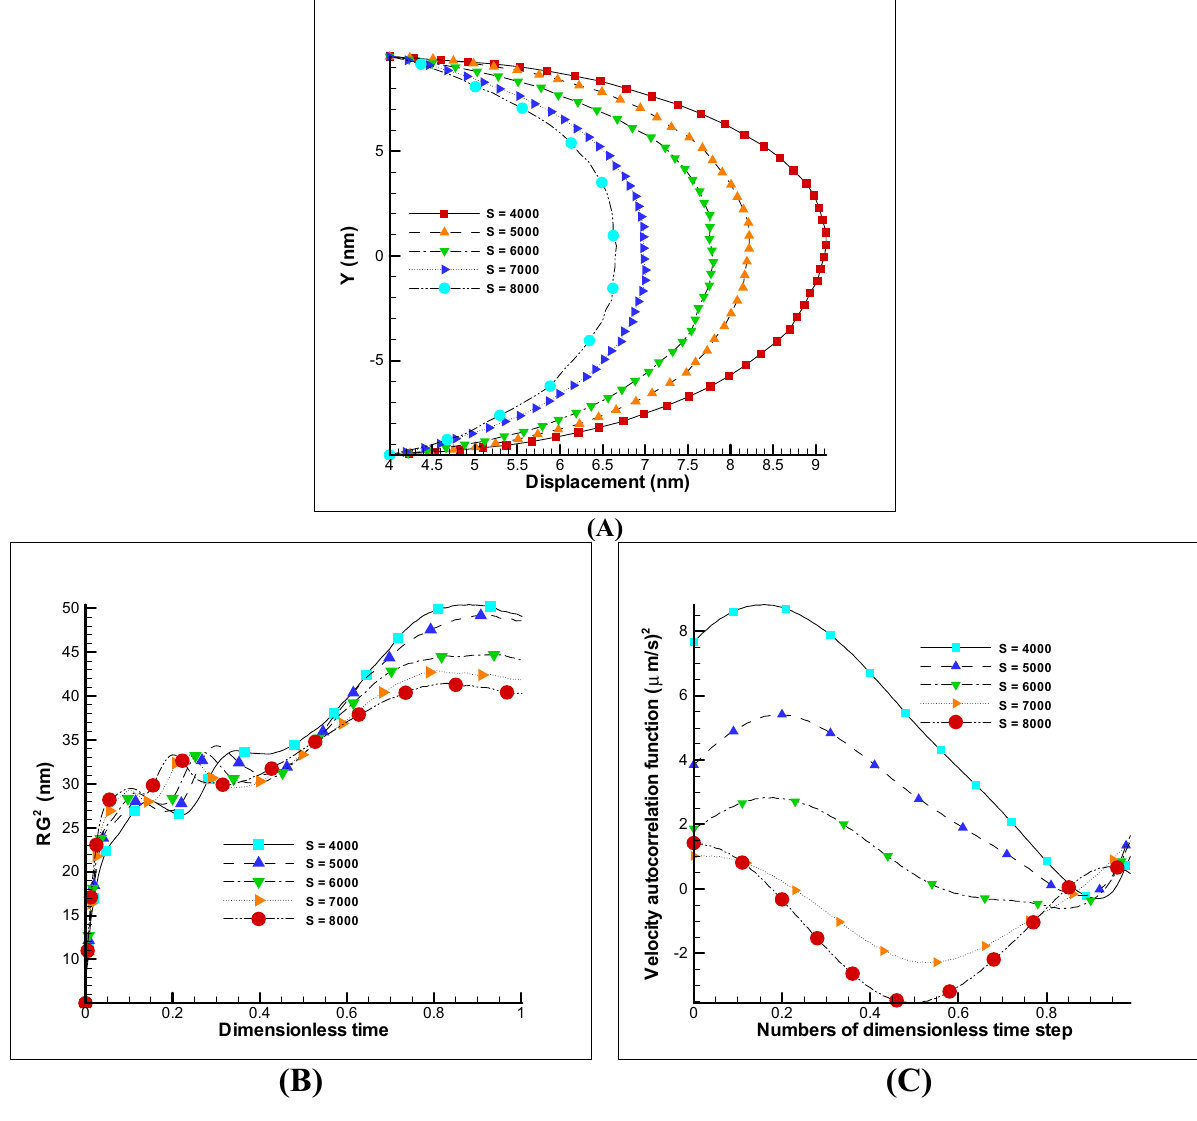
Figure 10. Effect of harmony bond coefficient on membrane. Displacement of polymer chain in EOF for different harmony bond coefficient ( A ). Changes of radius of gyration and VACF over dimensionless time (t/ t max ) considering different harmony bond coefficient ( B